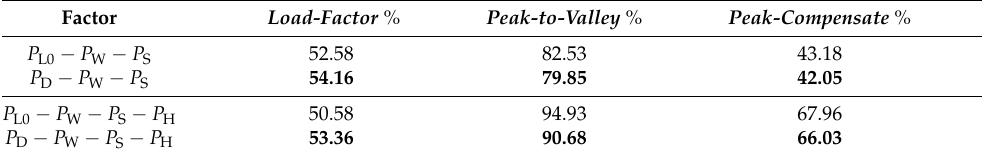
Figure 5. The load characteristics considering DR and pumped hydro storage. Table 3. The comparison of load